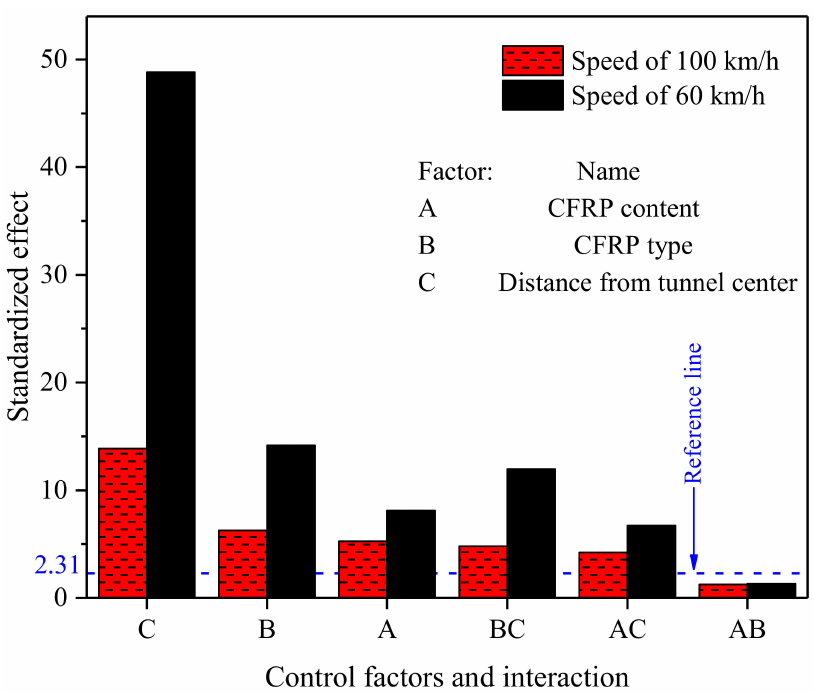
Figure 25. Pareto diagram of the standardized effect for vibration propagation